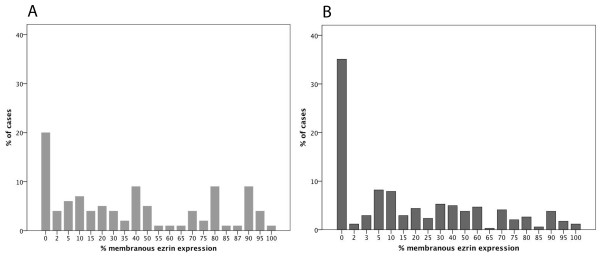
Distribution of ezrin expression in two independent patient cohorts. Bar charts visualizing the distribution of different percentages of ezrin expression in (A) cohort I (n = 100) and (B) cohort II (n = 342).